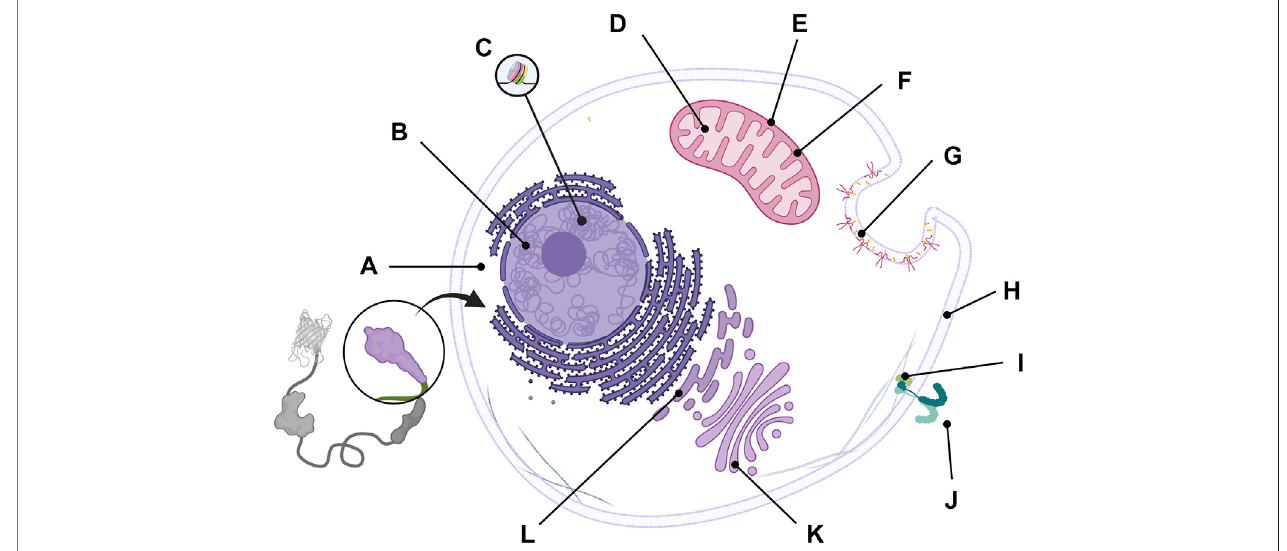
FIGURE 5 | Representative localization signal to guide GEBs at speci fi c cellular microdomain. The biosensors can be placed at (A) cytosol by attaching nuclear export signal (NES), (B) nucleus by including nuclear localization signal (NLS), (C) a nucleosome subunit by using Histone H3, (D) mitochondrial matrix by attaching mitochondrial targeting sequence (MTS), (E) mitochondrial outer membrane by containing C-terminal sequence of Bcl-xl, (F) mitochondrial intermembrane region by including leader sequence from the second mitochondria derived activator of caspases (SMAC), (G) lipid raft by using Lyn acylation substrate sequences, (H) nonraft by attaching K-Ras prenylation sequences, (I) IRS-1 working site by using PH and PTB domain of IRS-1, (J) Extracellular region by including Ig κ -chain leader sequence and PDGFR transmembrane domain, (K) Golgi apparatus by attaching eNOS targeting domain, and (L) endoplasmic reticulum (ER) by containing calreticulin signal sequence (CRsig) and ER retention sequence (KDEL).